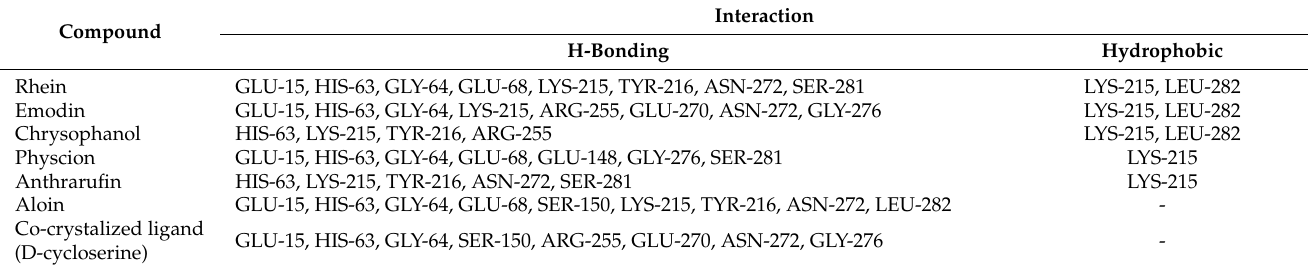
Figure 4. RMSDs of active top-scoring hits against inside the active site of Ddl-B and Gyr-B ( A , B , respectively). RMSD of the unsubstituted anthraquinone was also studied to highlight the role of hydroxylation in the stability of this type of compounds. Table 3. Interactions of the active Ddl-B top-scoring compounds inside the enzyme active site.